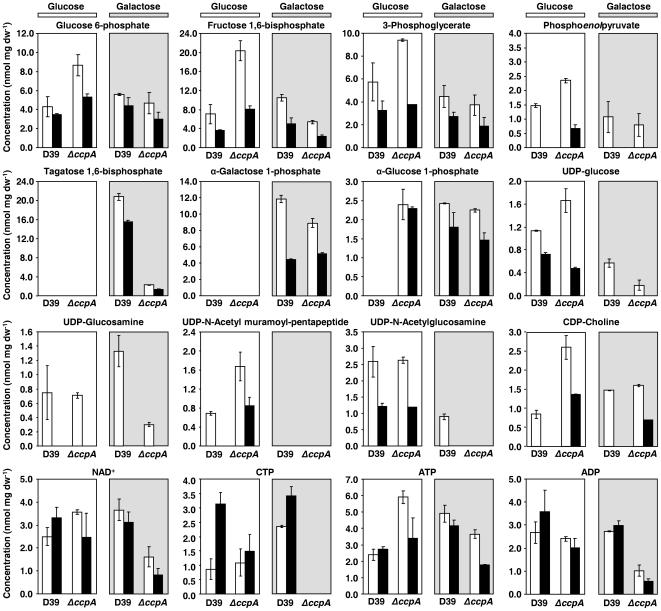
Effect of ccpA deletion on intracellular concentrations of phosphorylated metabolites during growth on Glc or Gal.Phosphorylated metabolites were measured by 31P-NMR in ethanol extracts of S. pneumoniae D39 and ΔccpA strains grown to mid-exponential (M, white bars, OD600 of 0.35±0.02) or transition-to-stationary phases (TS, black bars, OD600 of 1.3±0.1) of growth in CDM supplemented with 56±1 mM Glc (white background) or 57±1 mM Gal (light grey background). Phosphorylated metabolites measured in extracts comprised glycolytic metabolites, phosphorylated carbohydrate-specific metabolites, UDP-activated metabolites, and co-factors. The values are the mean of three independent experiments ± SD.